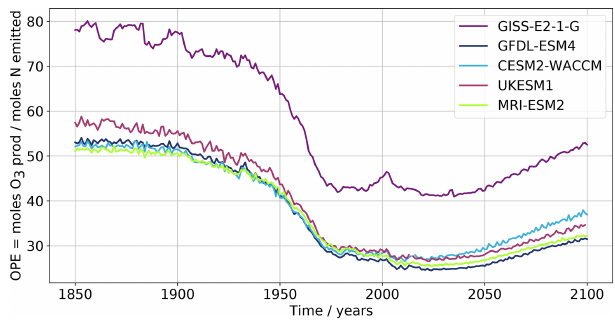
Figure 16. Variation in ozone production efficiency (OPE) for the five models. Individual models are shown, as in the figure caption